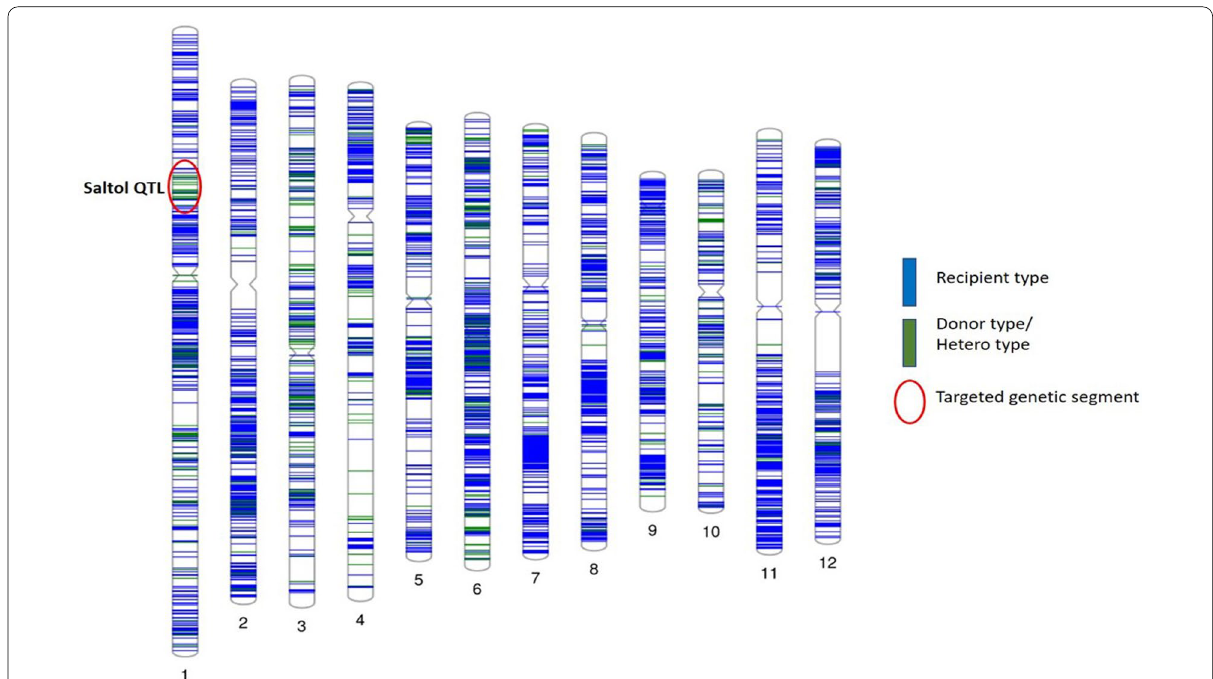
Fig. 3 Graphical representation of Recurrent Parent Genome similarity of Saltol QTL with the ISM using 90 K